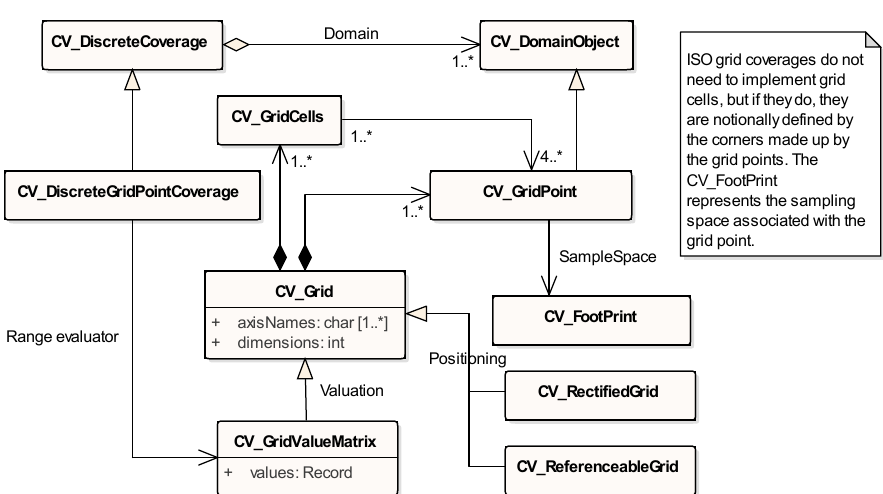
Figure 12. Key concepts within the ISO 19123 view of coverages and the associated coordinate systems: (a) as applied to a specific coverage: the discrete coverage, which relates a domain of objects to a set of attribute values; (b) an expanded view of the relationship of discrete grid point coverages to grid cells, grid footprints, and three different ways of thinking about the grids (set of coordinates, rectified, and referenceable grids). Note the comment box defining the two-letter labels of each element (e.g. CV indicates that this element comes from the ISO 19123 data model). See also Fig. 9 in Dominico and Nativi (2013). Further relationships and details are discussed in the text.